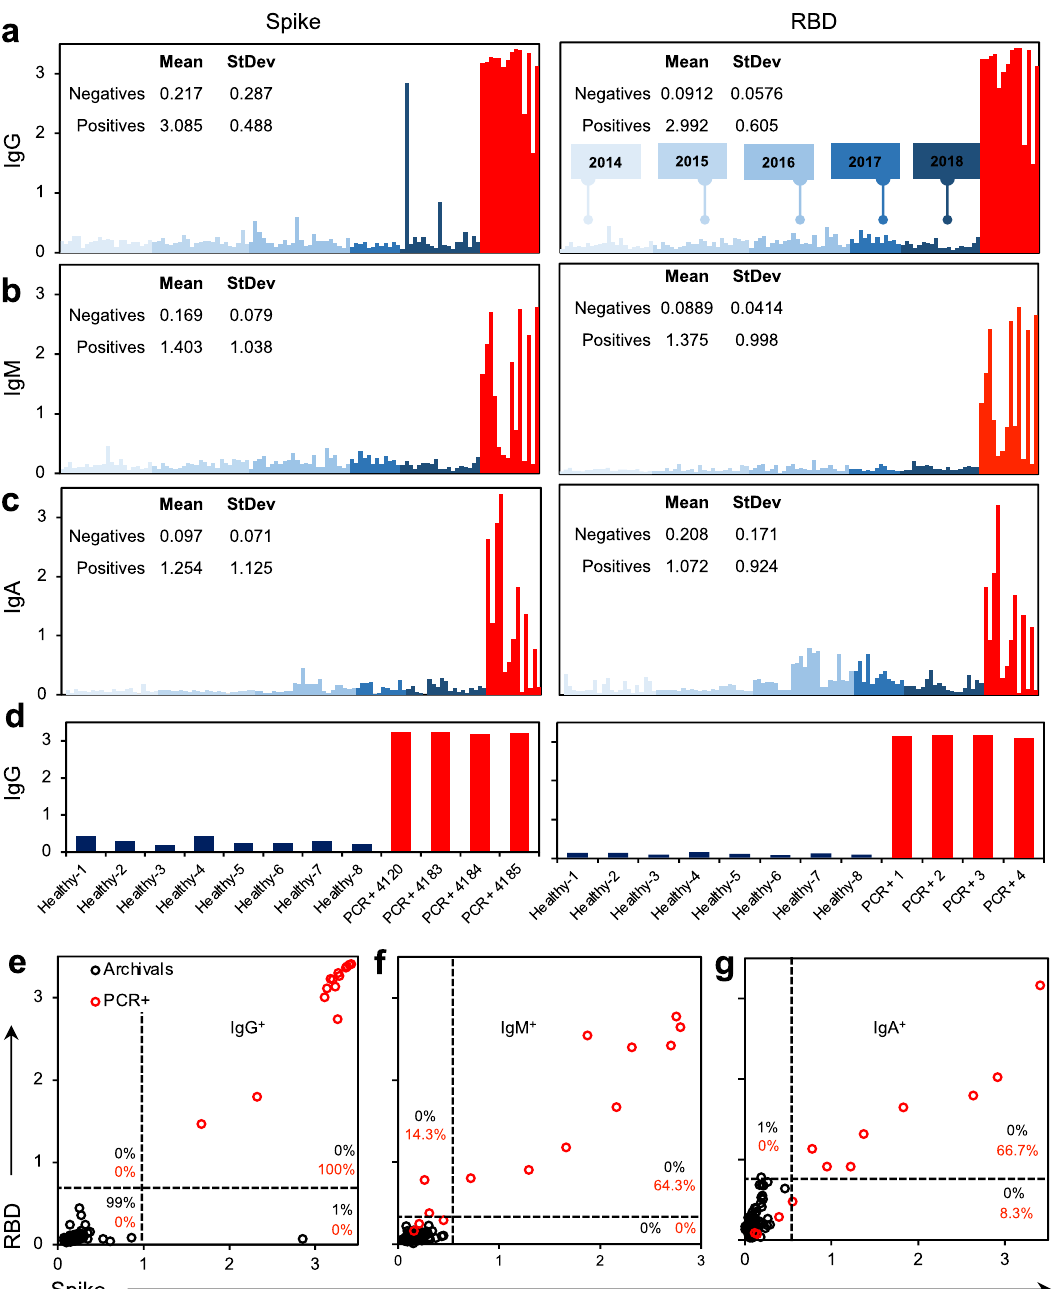
Fig. 3 Speci fi city of antigens against a preliminary panel of pre-2019 archival sample controls. a – c Spike (McLellan/VRC) and RBD (Ragon) antigens tested against 100 archival controls collected from 2014 to 2018 (blue) compared with 14 SARS-CoV-2 PCR + controls (red) for a IgG, b IgM, and c IgA. d Microsampler controls of PCR + samples against healthy controls. e – g Seropositivity thresholding for e IgG, f IgM), and g IgA calculated from average signal intensity of archival controls. n = 100 archival controls (black), n = 14 nasal swab SARS-CoV-2 PCR + patients (red). Manual ELISA, titer = 1:400 (serum) or 1:10 (microsampler eluate). Source data are provided as a Source Data fi